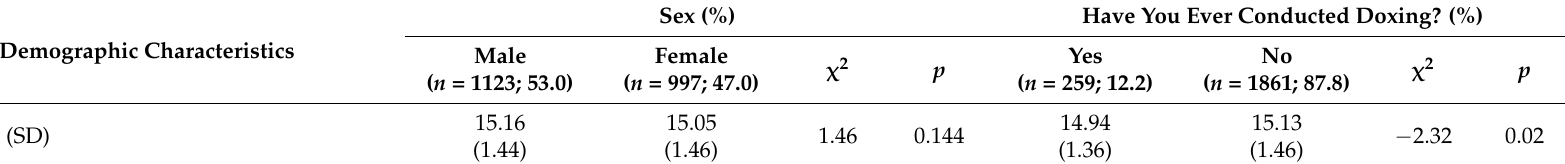
Table 1. Demographic characteristics of